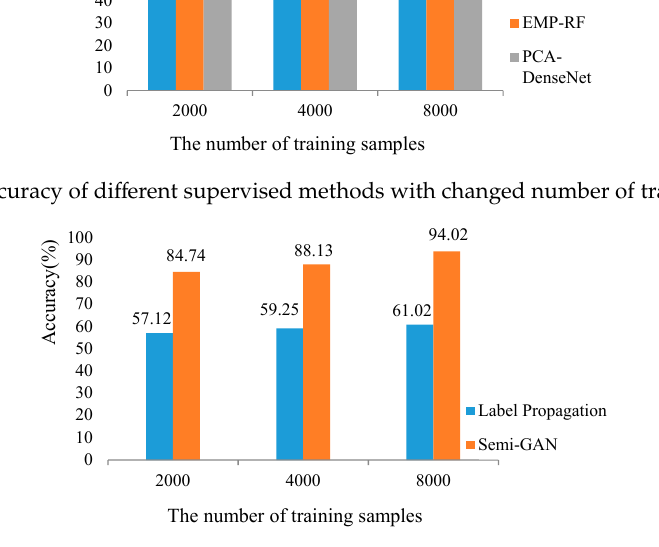
Figure 7. Test accuracy of di ff erent semi-supervised methods with changed number of training samples.